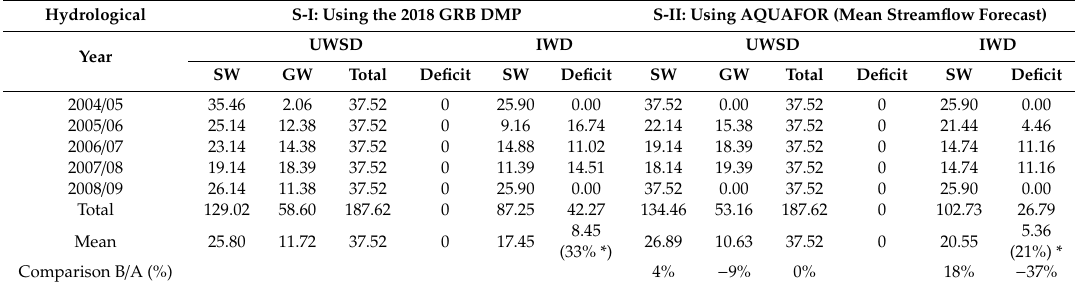
Table 6. Volume (hm 3 ) of water used and e ffi ciency in satisfying the water demands.